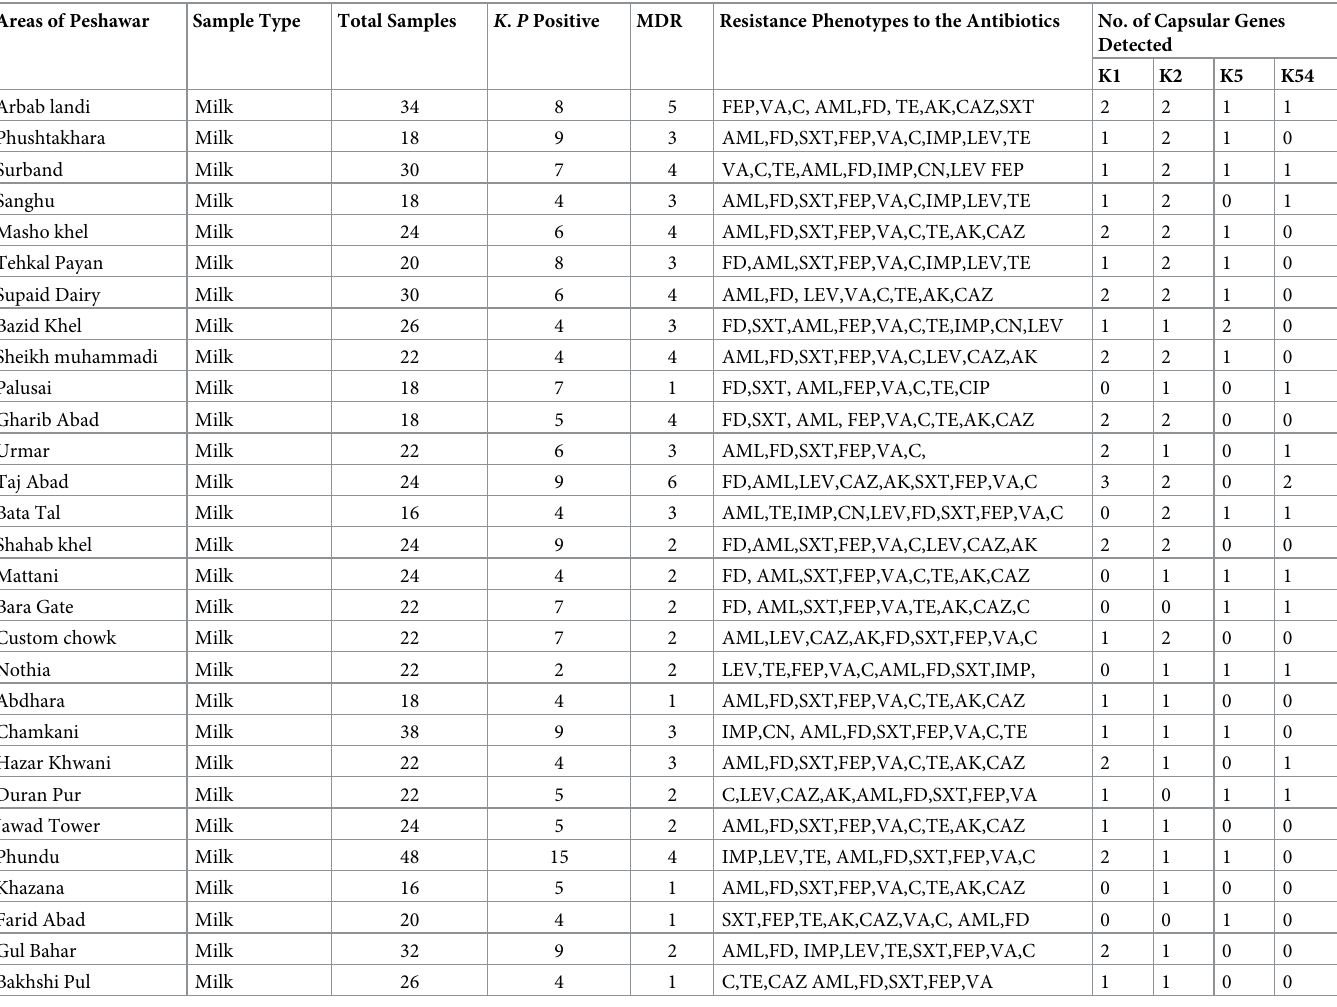
Table 3. Overall area-wise distribution of MDR K . pneumoniae , phenotypes to the antibiotics, and capsular resistance genes in district Peshawar, Pakistan. Areas of